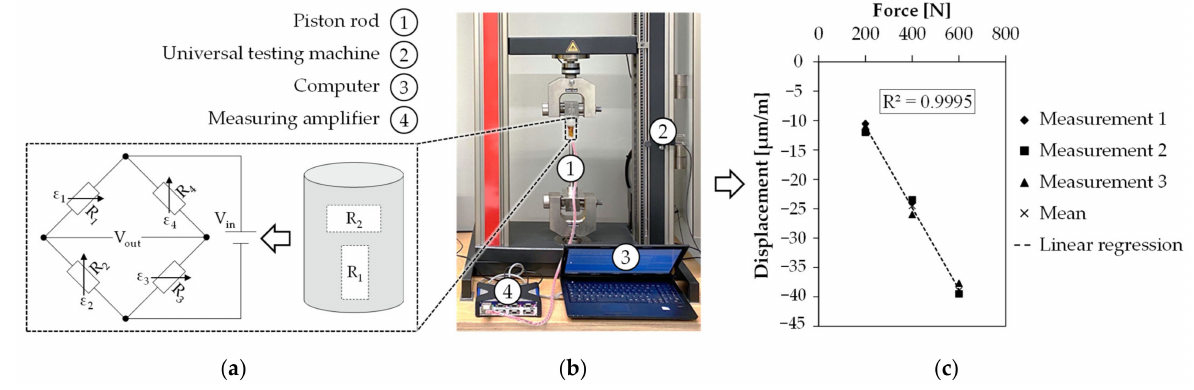
Figure 4. ( a ) Wheatstone full bridge circuit with four active strain gauges; ( b ) experimental setup for calibration; ( c ) results of